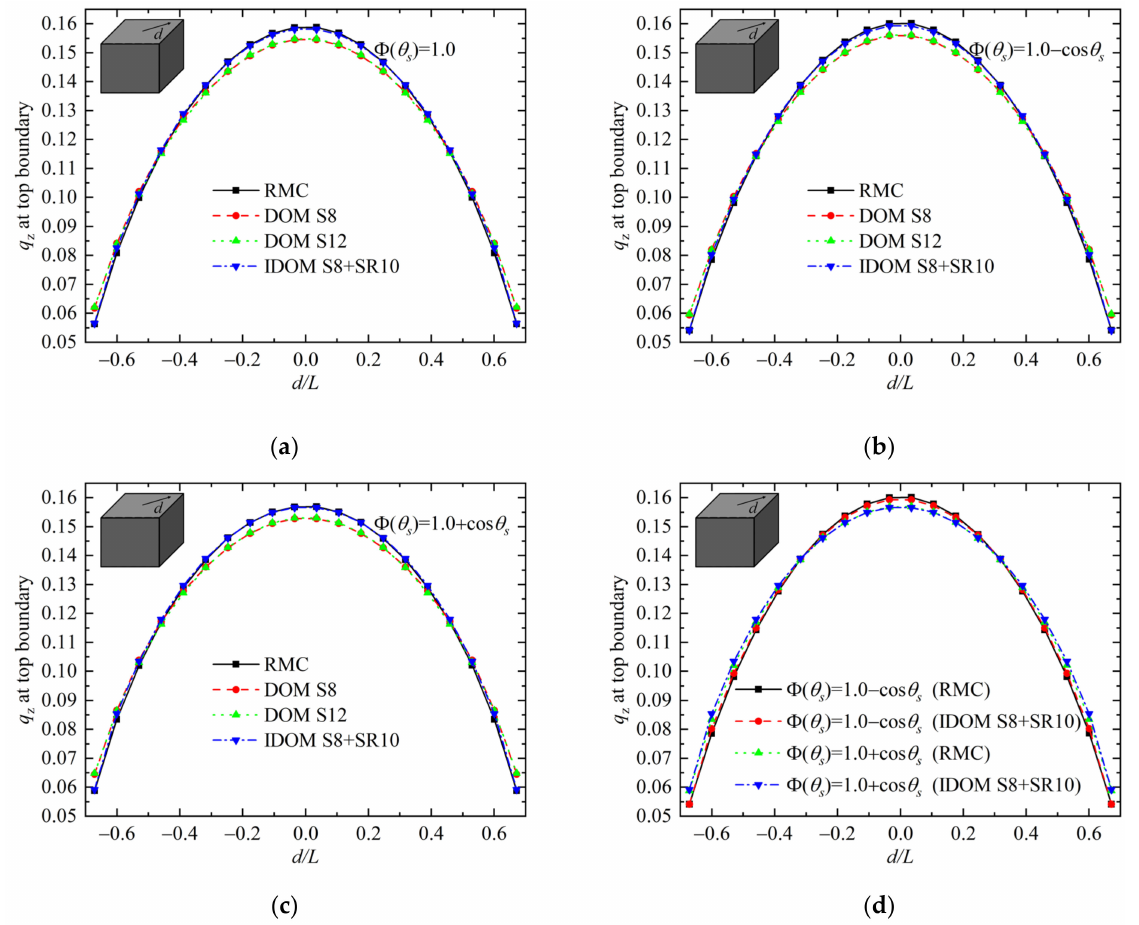
Figure 5. Heat flux at the boundary of Case 3: ( a ) results for A 1 = 0; ( b ) results for A 1 = − 1; ( c ) results for A 1 = 1; ( d ) results comparison for A 1 = − 1 and